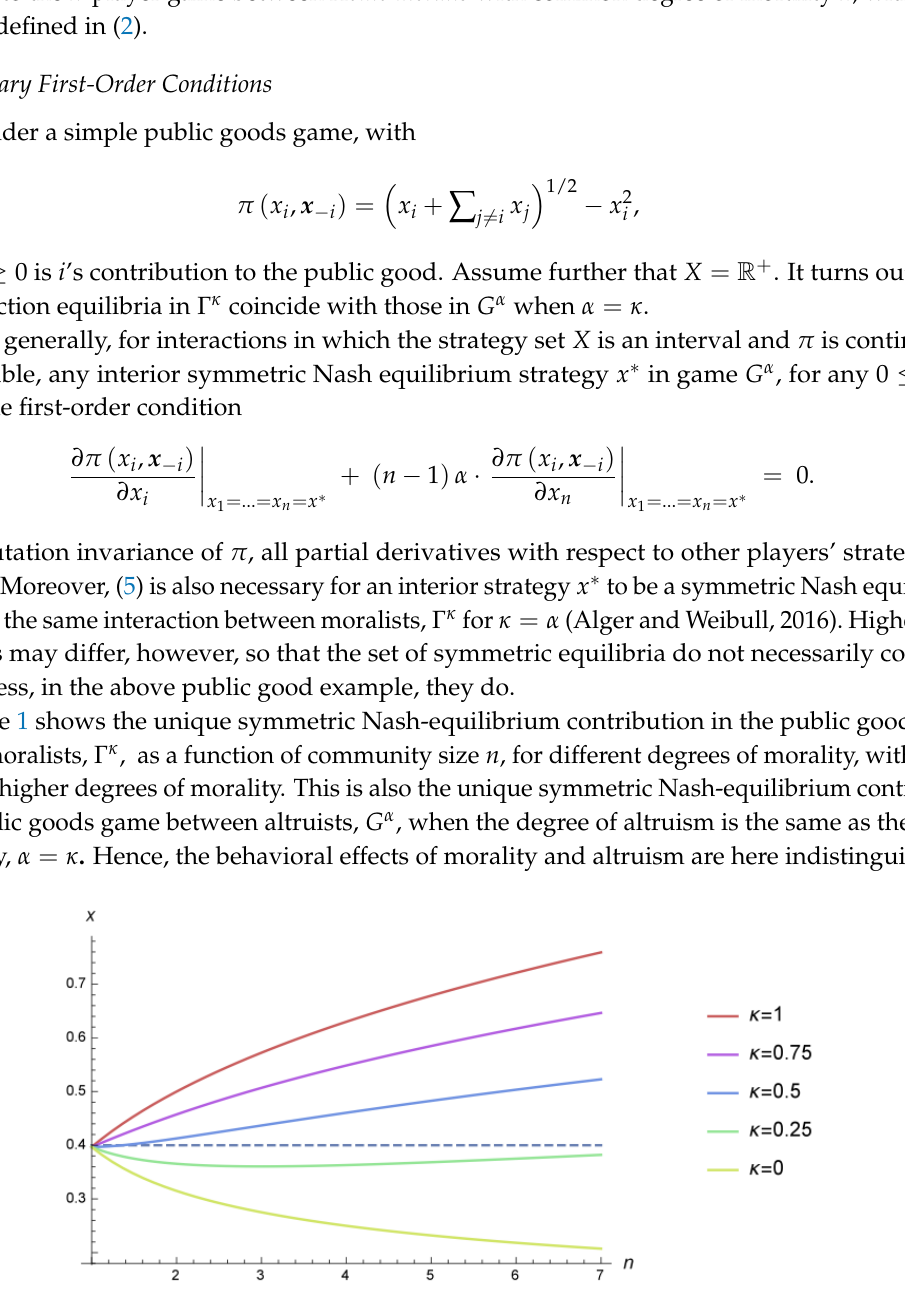
Figure 1. The unique Nash equilibrium contribution in the public-goods game for different degrees of Figure 1: The unique Nash equilibrium contribution in the public-goods game for di⁄erent degrees of morality.